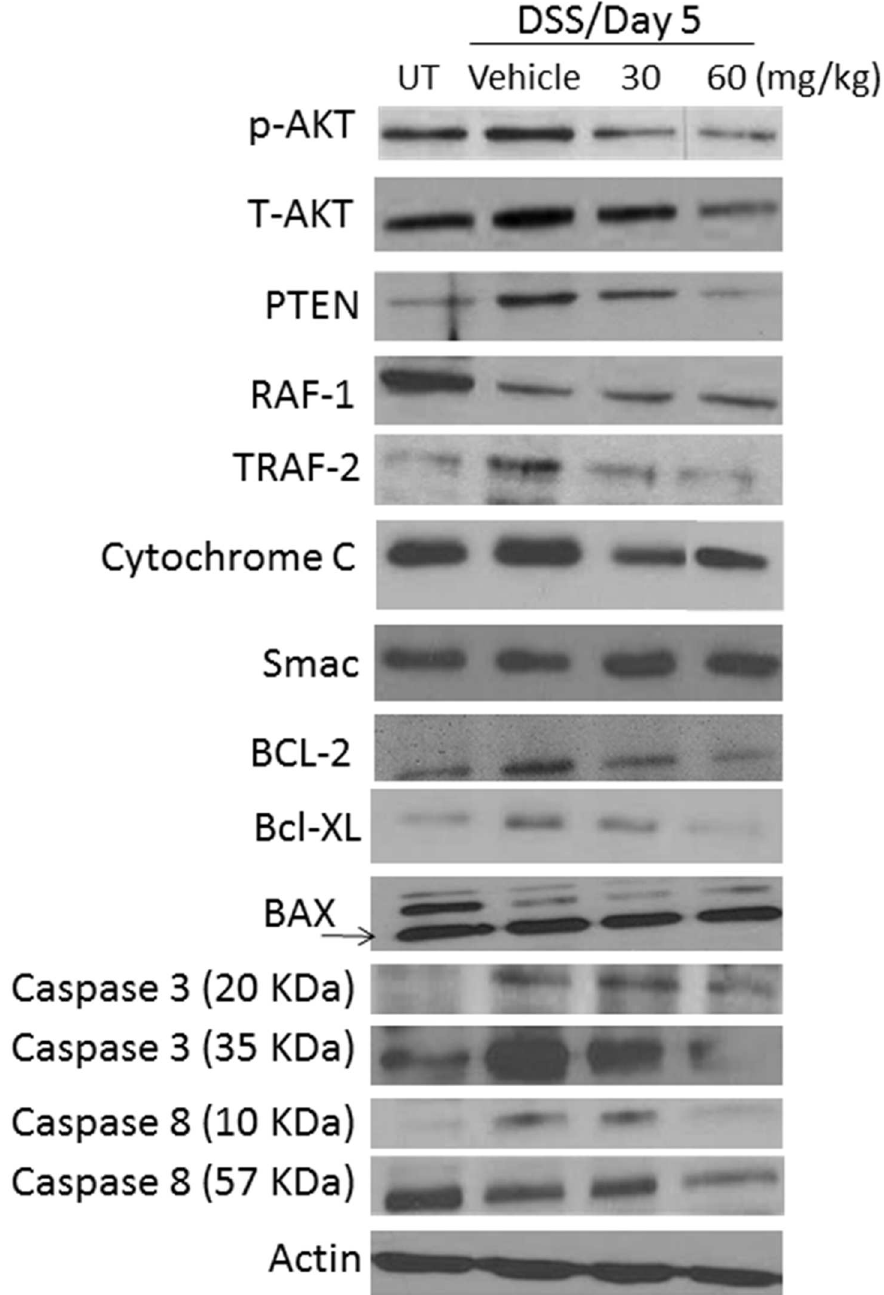
Fig 5. Effect of E121 on total/phosphorylated levels of proteins involved in cell signaling and apoptosis. Coloniclevels of variousproteins involvedin cell signalingand apoptosiswere determined by western blottingin UT or mice treated with either vehicleor E121 (30 and 60 mg/kg) at day 5 post colitis induction. The blots represent one of 3 similar